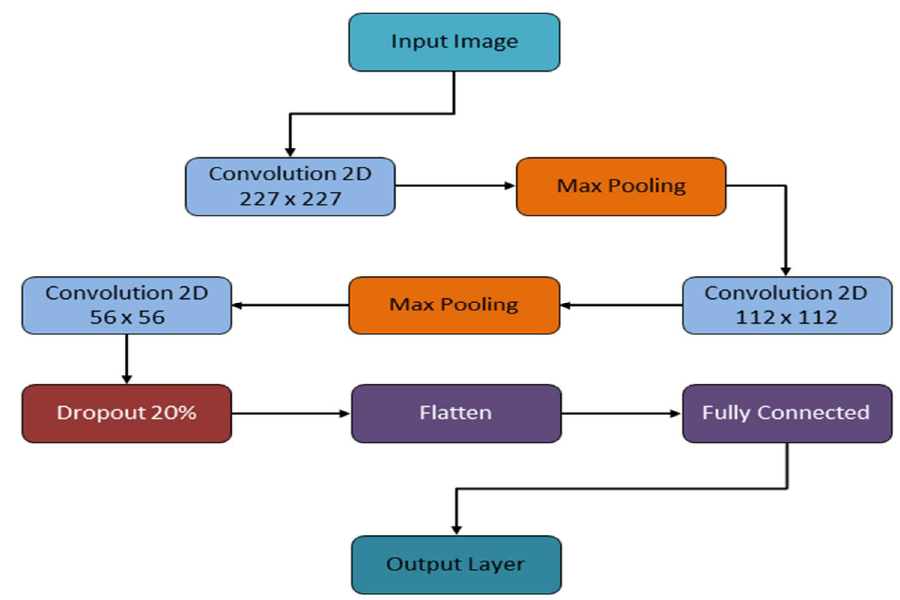
Figure 6. The architecture of the proposed CNN model.